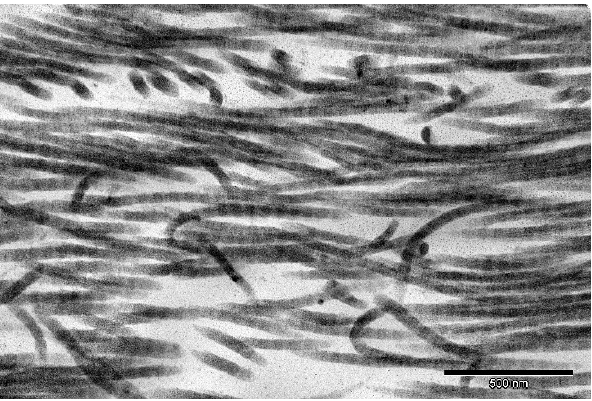
Figure 9. TEM image of decellularized pancreas (magnification 80 kx).